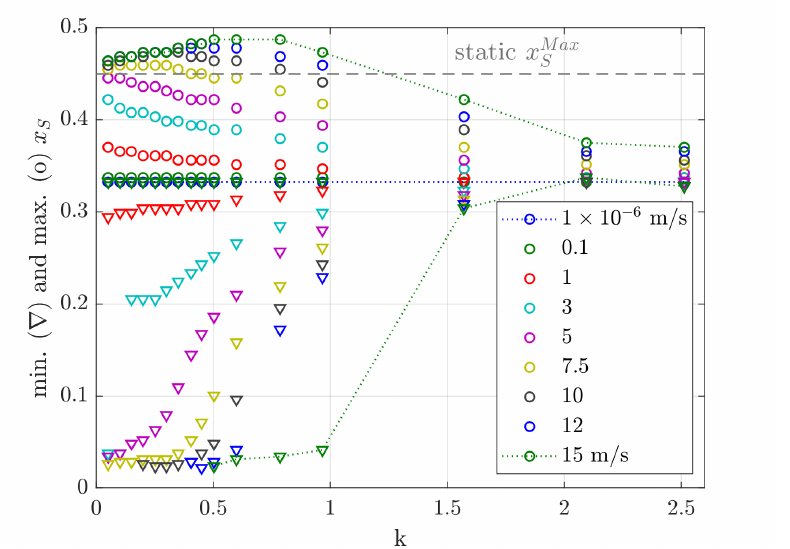
Figure 13. Minimum and maximum x-coordinates for the shock position during one period of excitation at Mach 0.70.